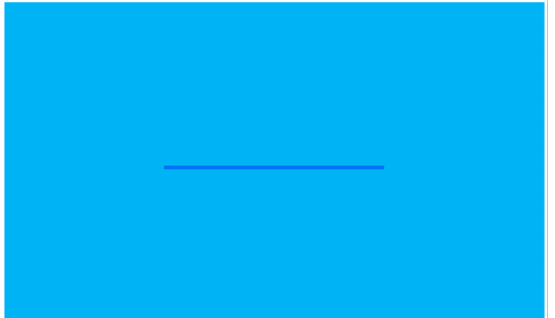
Figure 1. Dual porosity Assigned Grid (Dark blue) for Hydraulic